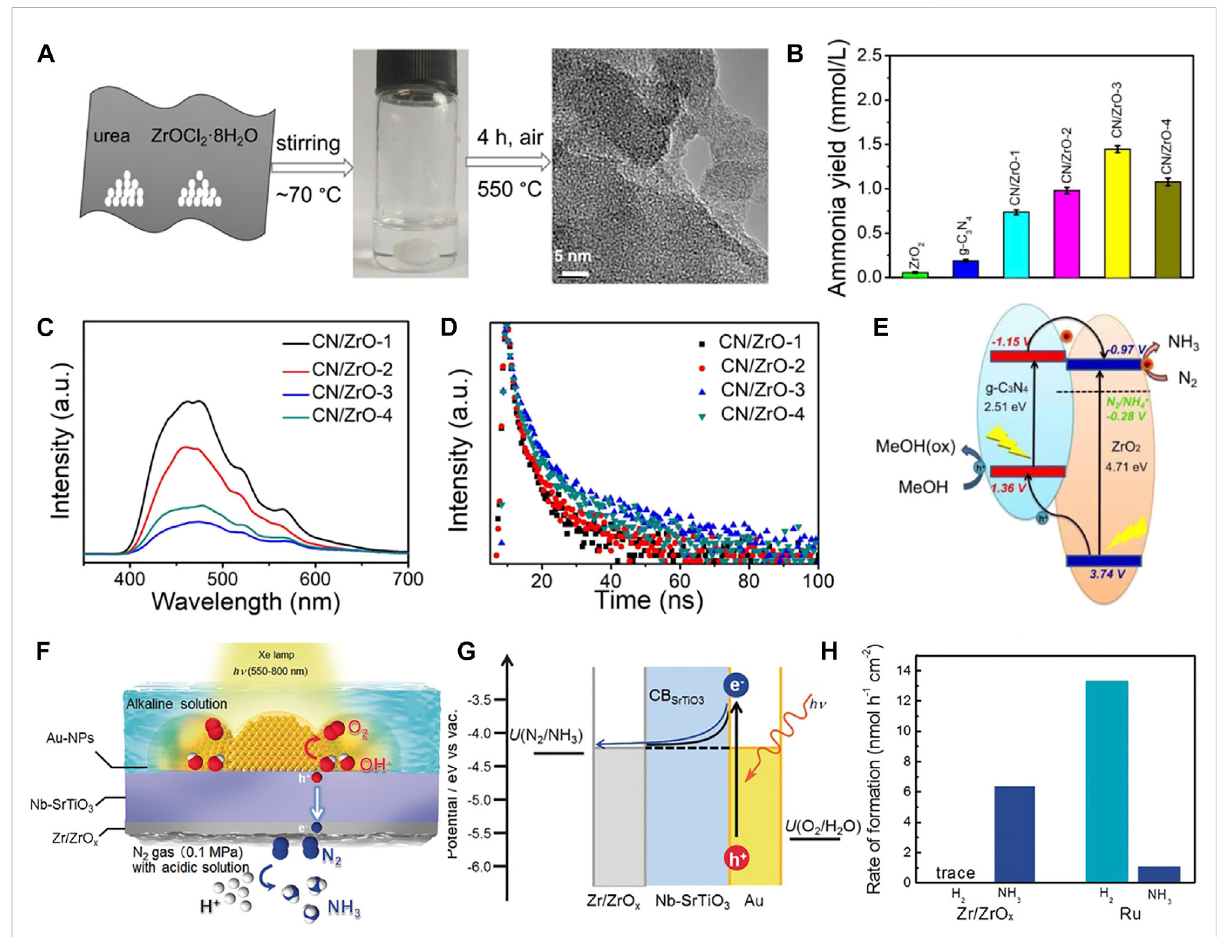
FIGURE 7 (A) Schematic of g -C 3 N 4 /ZrO 2 composite synthesis. (B) NH 3 yields of pure ZrO 2 , g-C 3 N 4 and g -C 3 N 4 /ZrO 2 composites with different ZrO 2 contents. (C) Photoluminescence (PL) spectroscopy and (D) time-resolved PL (TRPL) decay spectra. (E) Schematic of mechanism for photocatalytic N 2 fi xation over g -C 3 N 4 /ZrO 2 composites. Reproduced from Mou et al. (2019) with permission from American Chemical Society. (F) Schematic of NRR on Au-NPs/Nb-SrTiO 3 /Zr/ZrO x photoelectrode. (G) Energy-level diagram of the plasmon-induced NH 3 synthesis device. U :